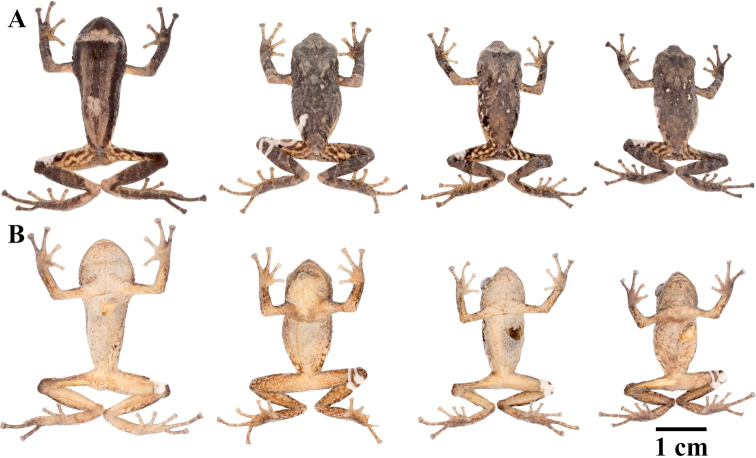
Color variation in preserved individuals of Pristimantis
teslai sp. nov. A Dorsal view of (from left to right): QCAZ 46209 (juvenile female), QCAZ 46108 (male), QCAZ 46211 (male), QCAZ 46208 (male) B Ventral view of specimens in A. See Suppl. material 2 for locality data. All specimens are shown at the same scale.